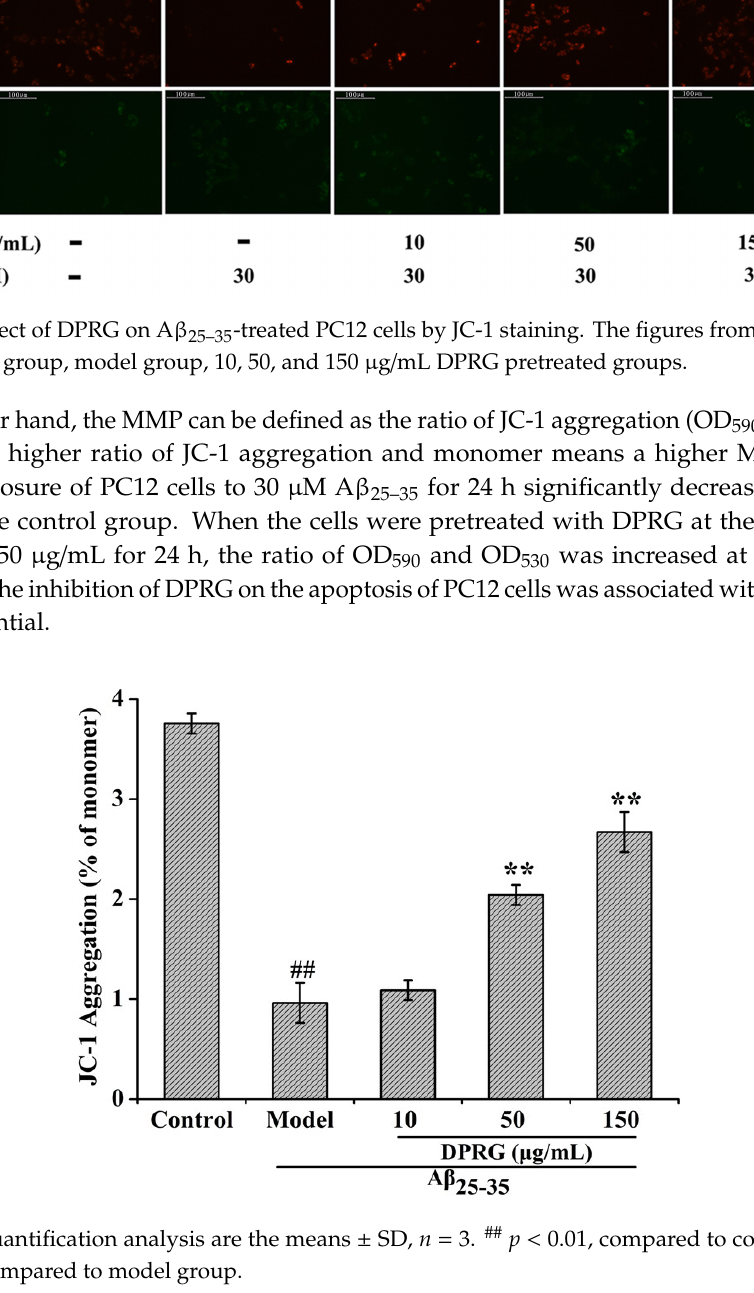
Figure 7. Quantification analysis are the means ± SD, n = 3. ## P < 0.01, compared to control group, ** p < 0.01 compared to model group.